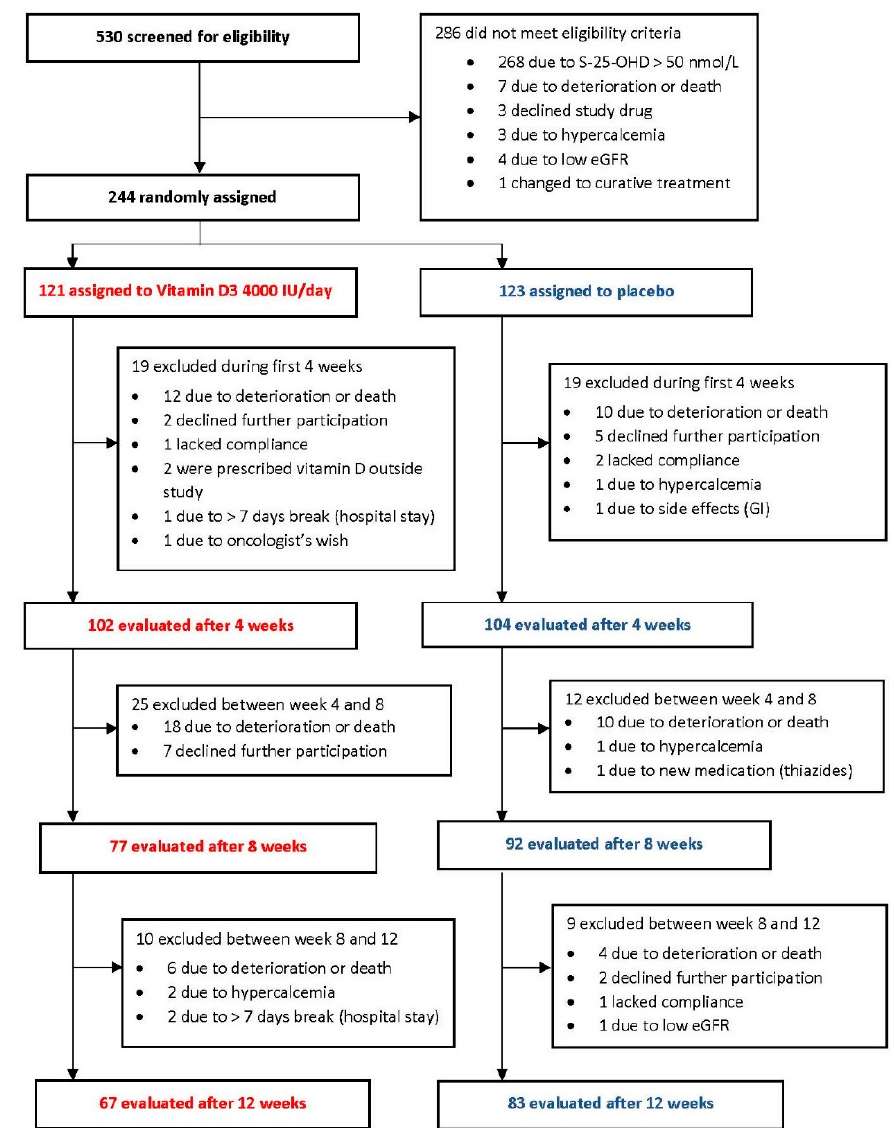
Figure 1. Flow chart of the included and excluded patients in the ‘Palliative-D’ study.